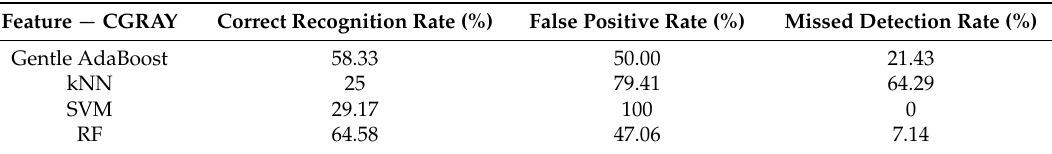
Table 6. Experimental results of constructing different recognition models based on comprehensive gray (CGRAY).